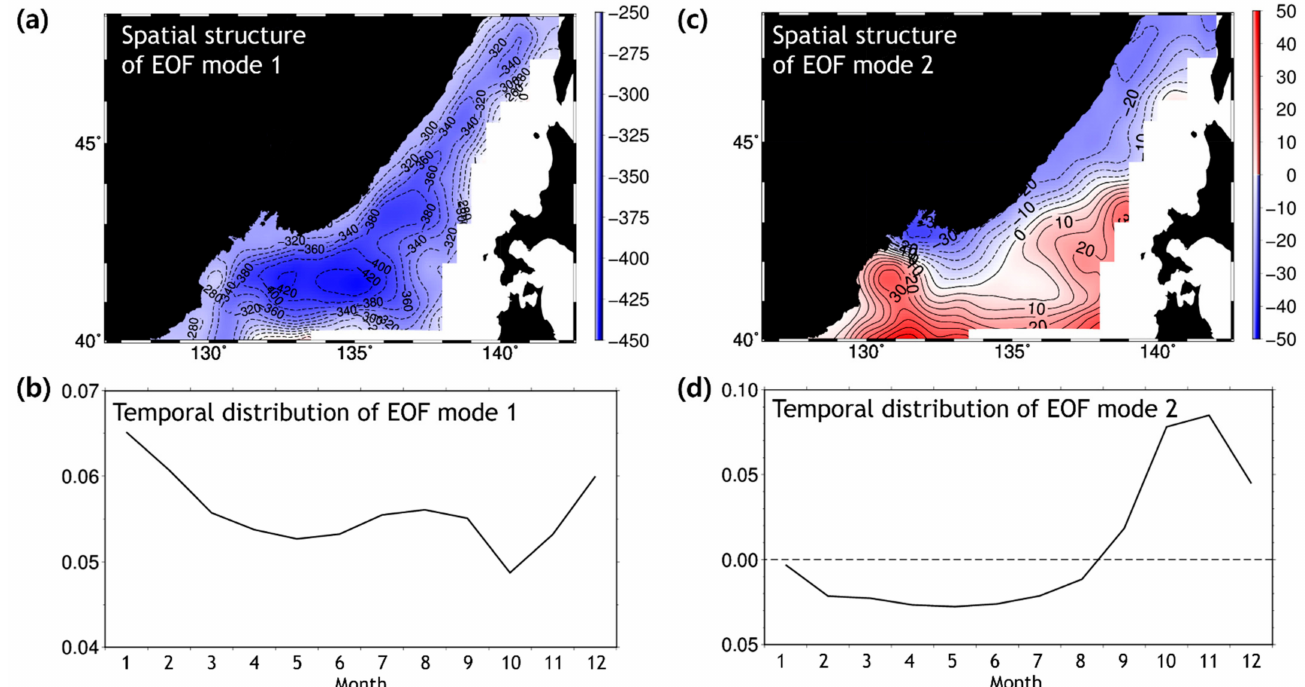
Figure 2. The first two EOF modes of the SSH variability over the NES: ( a , c ) spatial structures of EOF modes 1 and 2, ( b , d ) time series of climatological monthly mean temporal distribution of EOF modes 1 and